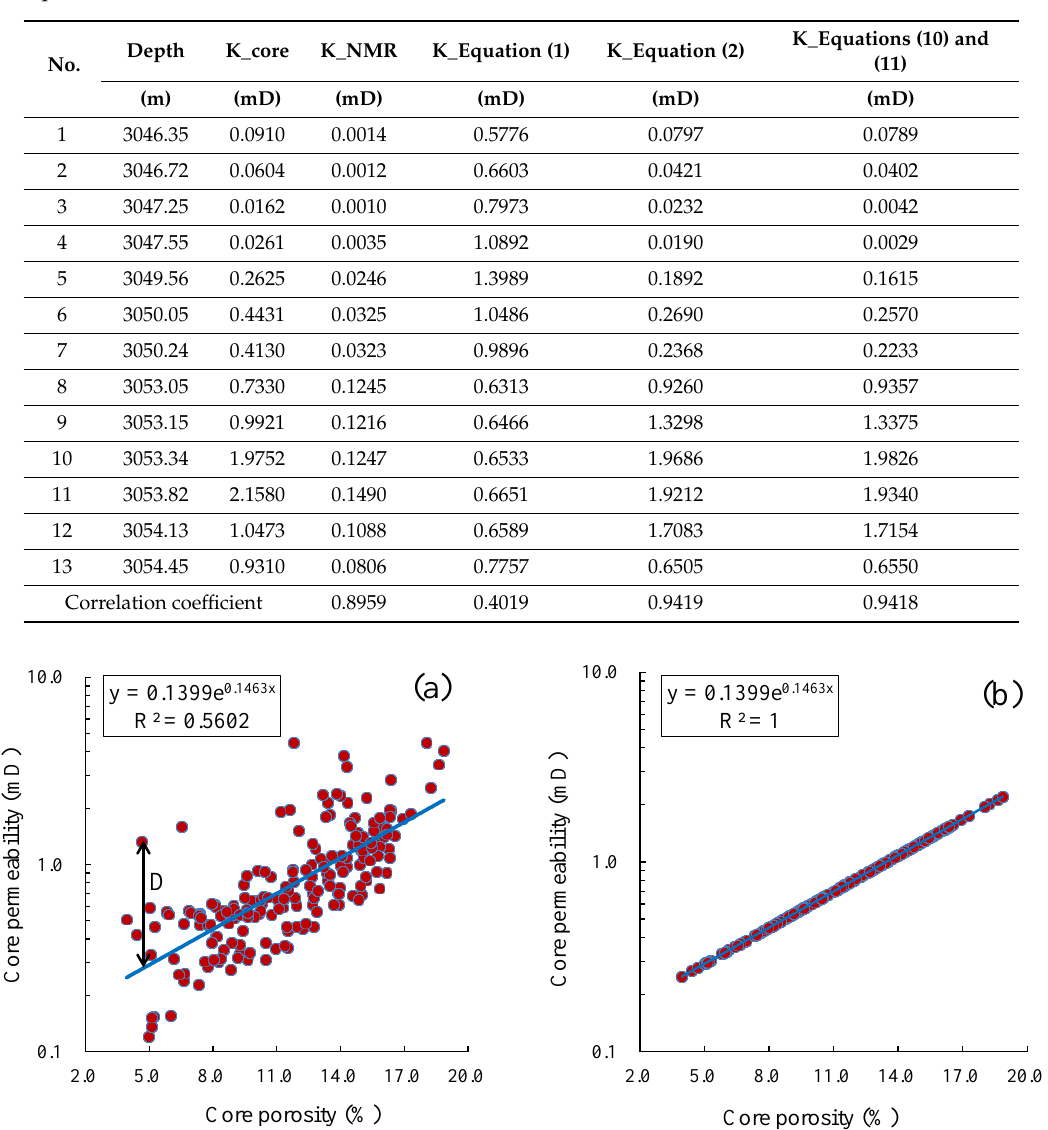
Table 3. The result of permeability calculation of the JX well and its correlation coe ffi cient with core sample permeability, where K_Equations (10) and (11) represents the permeability calculated by Equations (10) and (11).